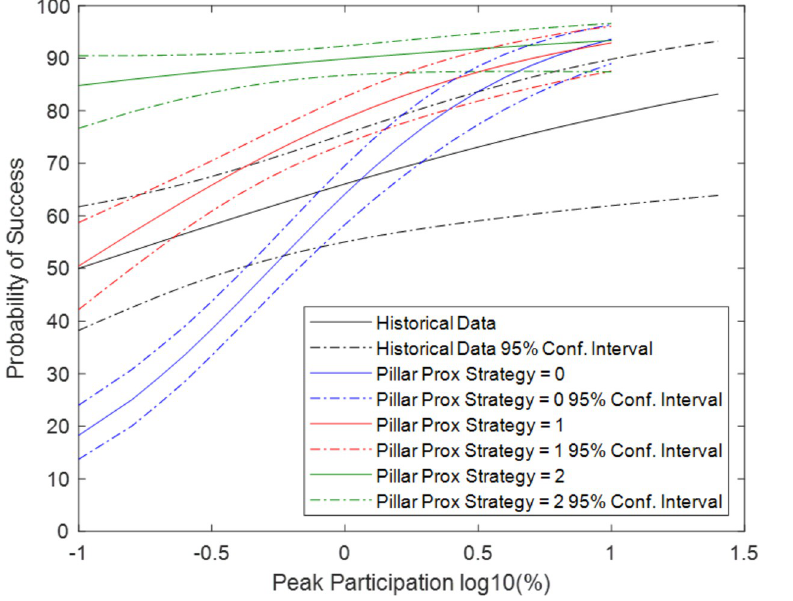
Fig 8. Comparing probability of success for Pillar Proximity